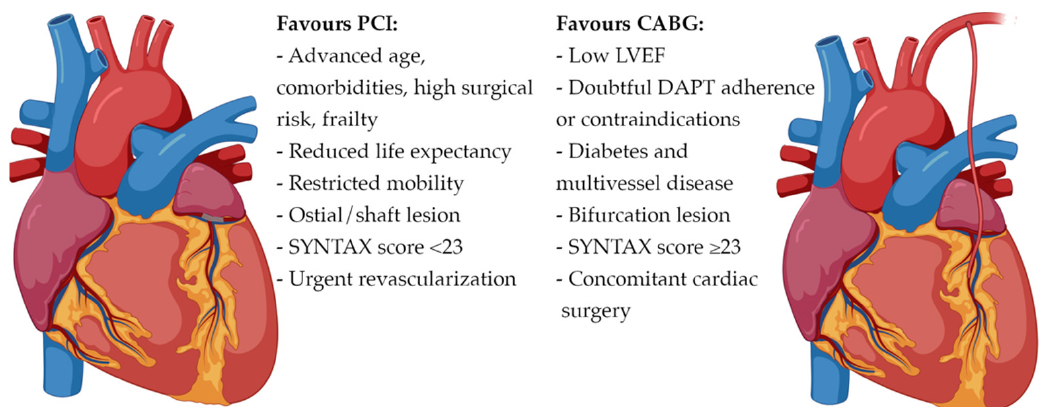
Figure 3. Indications for percutaneous coronary intervention and coronary artery bypass grafting in left main coronary artery disease. CABG–coronary artery bypass grafting, DAPT–dual antiplatelet therapy, LVEF–left ventricular ejection fraction, PCI–percutaneous coronary intervention, SYNTAX - Synergy Between Percutaneous Coronary Intervention With TAXUS and Cardiac